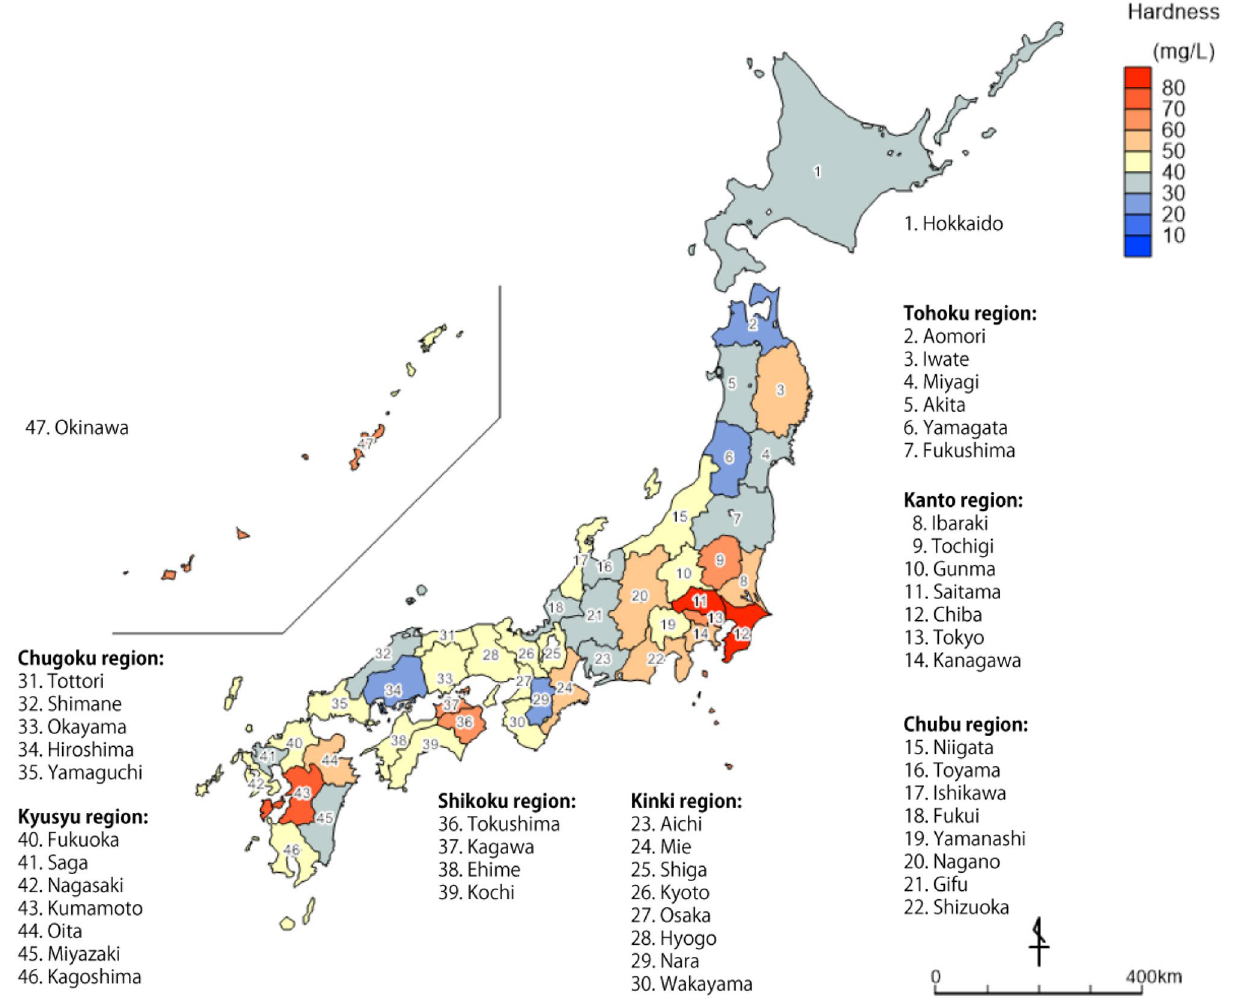
Figure 3. Map of Japan showing the distribution of water hardness (prefecture average). No. 1: Hokkaido, 2–7; Tohoku region, 8–14; Kanto region, 15–22; Chubu region, 23–30; Kinki region, 31–35; Chugoku region, 36–39; Shikoku region, 40–46; Kyusyu region, 47; Okinawa. The map was self-drawn by using Adobe Illustrator